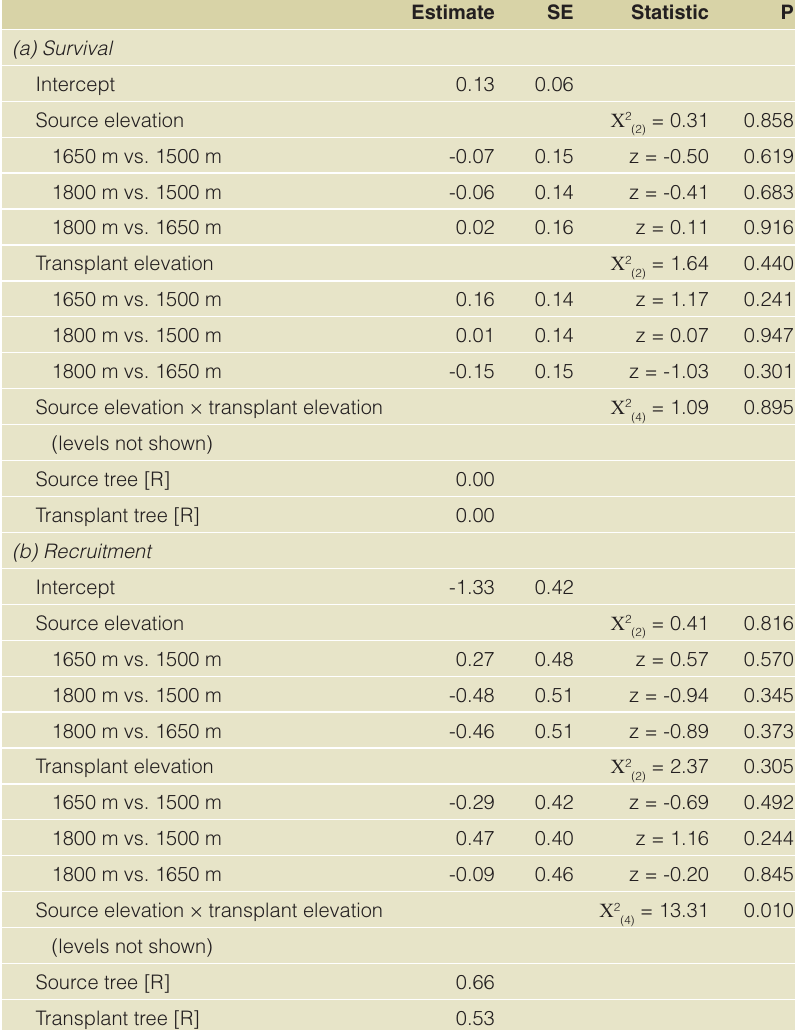
Table 5. Results of generalized linear mixed-effects models (GLMMs) for all species in mats transplanted between elevations. SE: standard error. Estimate SE Statistic